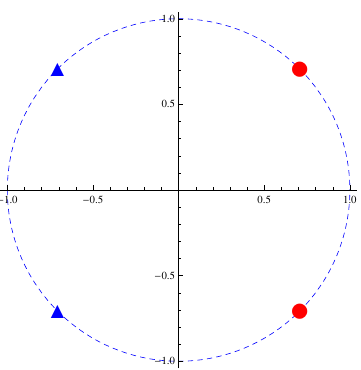
Figure 5 . The eigenvalue distribution of (cid:10) F for su (2) with a single fermion in the (4) representa- tion. Di(cid:11)erent vacua are labeled by di(cid:11)erent markers and distinct colors. The red (circle) vacuum p has tr F (cid:10) = 2, while the blue (triangle) vacuum has tr F (cid:10) = respects C , P , and T symmetries.